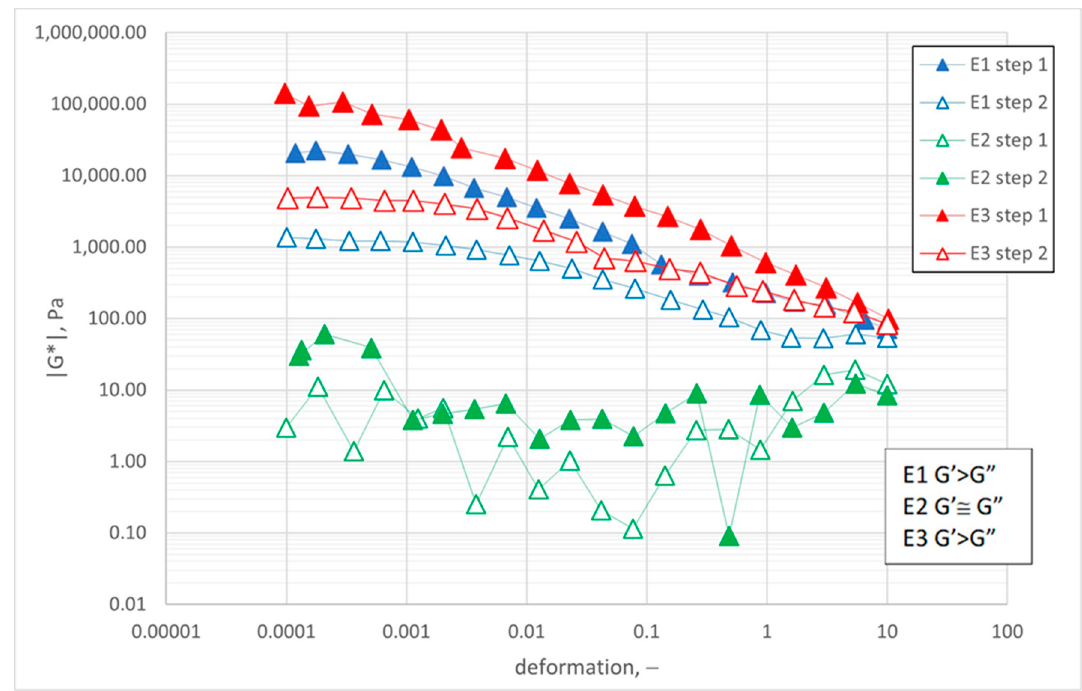
Figure 8. |G*| module against variable deformation for samples E1–E3.